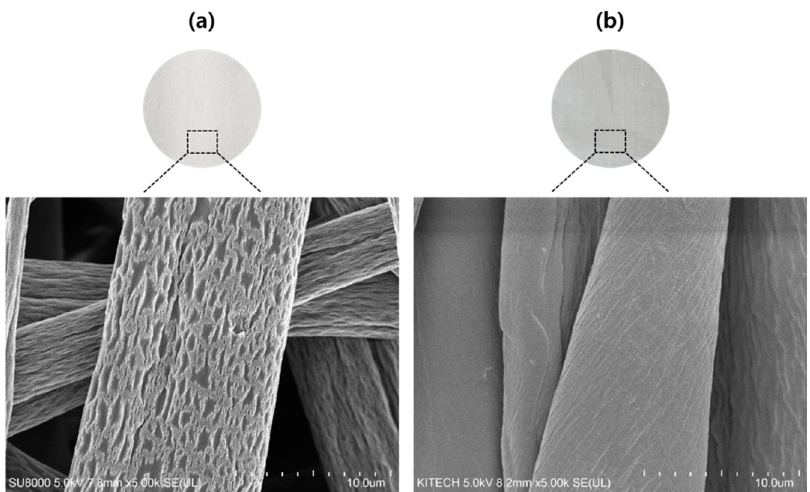
Figure 2. SEM images showing morphologies of: ( a ) electrospun cellulose acetate fiber; and ( b ) cotton fabric.